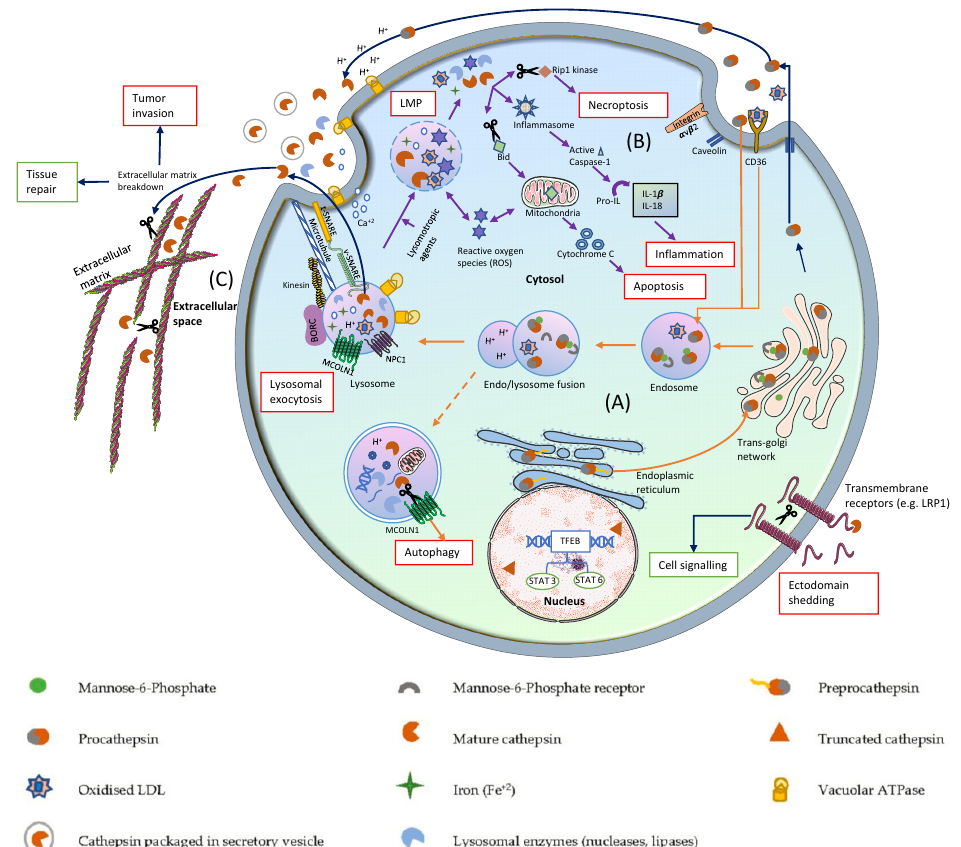
Figure 1. Site-specific functions of cathepsins. ( A ) cathepsins in the lysosomes (represented by orange arrows): Cathepsins are synthesized as preprocathepsins in the endoplasmic reticulum and transported to endo/lysosomes via Trans-Golgi network where the acidic pH enables their maturation. Cathepsins in the lysosomes are mostly involved in protein degradation besides participating in autophagy. ( B ) cathepsins in the cytosol (represented by purple arrows): Lysosomotropic agents, ROS or accumulation of modified lipids (oxLDL) leads to lysosomal membrane permeabilization (LMP), releasing cathepsins into the cytosol. Cytosolic cathepsins participate in various activities. For example, cathepsins trigger the inflammasome and promote apoptosis and necroptosis by cleaving various proteins. ( C ) Cathepsins in the extracellular space (represented by blue arrows): Lysosomal exocytosis involves the secretion of lysosomal contents into the extracellular space with the help of several protein-receptor interactions and Ca +2 ion gradient. Cathepsins are released in the form of procathepsins or enclosed in the secretory vesicles or as active cathepsins. Secreted cathepsins remain attached to the plasma membrane or are released into the extracellular space. Cathepsins on the plasma membrane cleave proteins like integrins. Secreted cathepsins mainly participate in extracellular matrix degradation and thus help in wound healing. However, excessive ECM cleavage facilitates tumor invasion and promotes cancer. While in the extracellular space cathepsins also shed the ectodomains of transmembrane receptors, leading to either activation or inhibition of cell signaling. ROS: reactive oxygen species; LMP: lysosomal membrane permeabilization; NPC1: Niemann–Pick disease type C1; CD36: cluster of differentiation 36; Figure is created with permission from Servier Medical Art image bank.